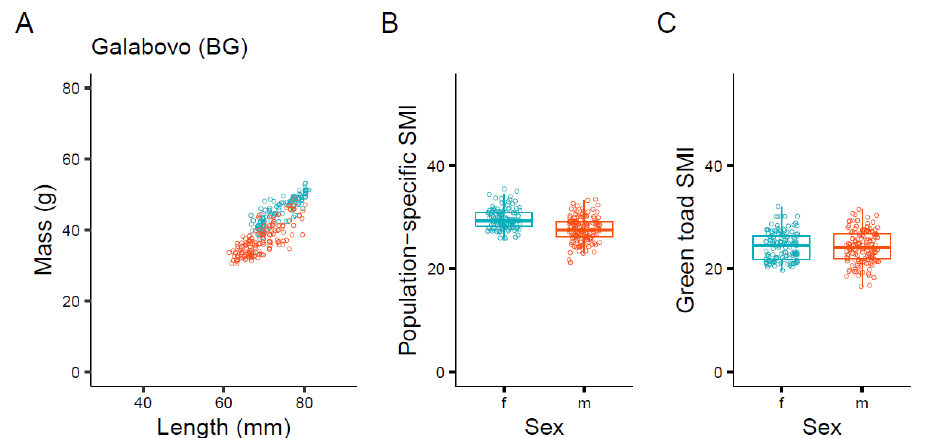
Figure 3. Mass versus lengths of toads in Galabovo (BG) ( A ) and the SMI of females and males using the population-specific coefficient ( B ) and the green toad coefficient ( C ). Boxplots show median (bold line), the 25th and 75th percentiles (lower and upper end of the box), as well as the 0% and 100% percentiles (lower and upper end of whiskers, excluding outliers). The reference length for SMI calculations was 60 mm and coefficient b was 2.042 (population-specific SMI) and 3 (green toad SMI).